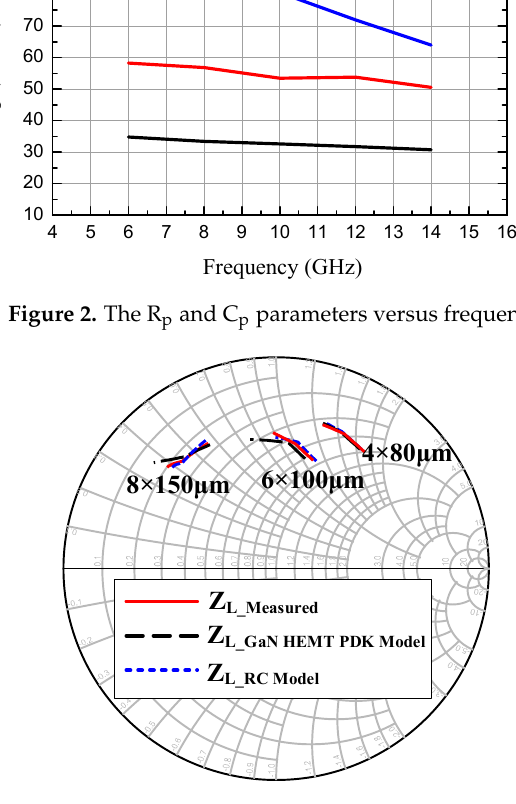
Figure 3. Comparison of 8–12 GHz optimal efficiency point impedance with measured, RC model, and GaN HEMT PDK model.